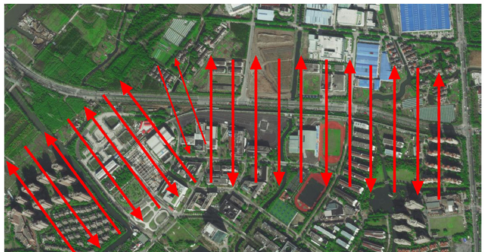
Figure 7. Oblique photography route plan of the magnetic levitation test line.